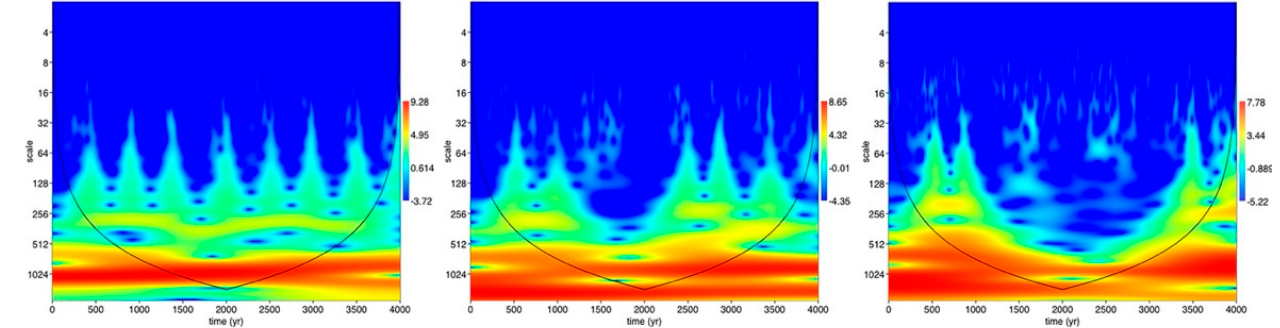
Figure 9. WT scalograms of the generalized Langevin’s equation solution for V 0 = 0, V 0 = 1, and V 0 = 2.5. As it can be seen, the temperature increase gave rise to a breaking of the stochastic resonance condition.